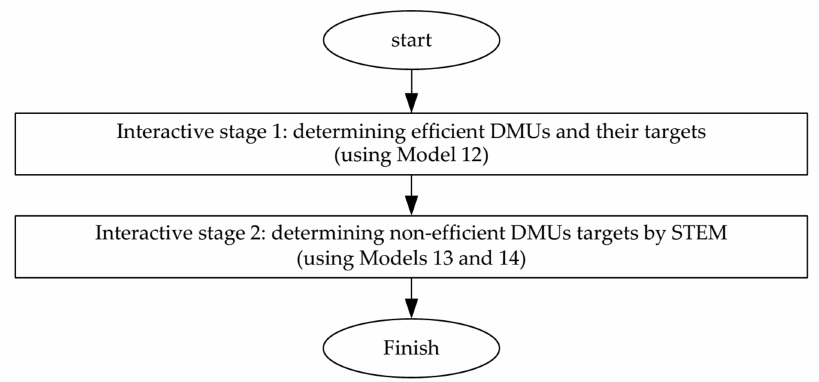
Figure 1. The interactive algorithm for finding DMU targets in non-radial FDH